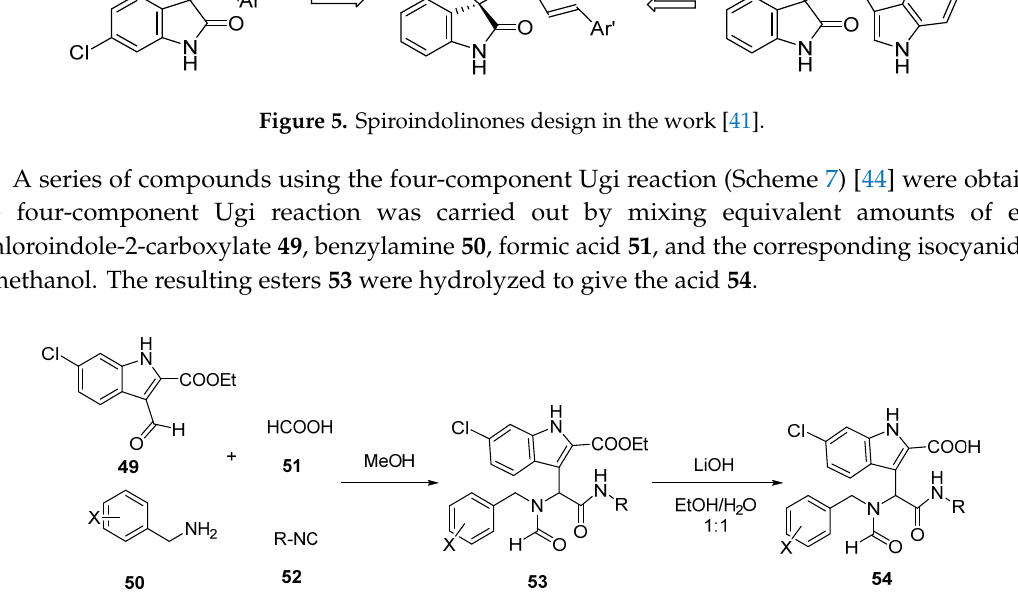
Figure 5. Spiroindolinones design in the work [41].